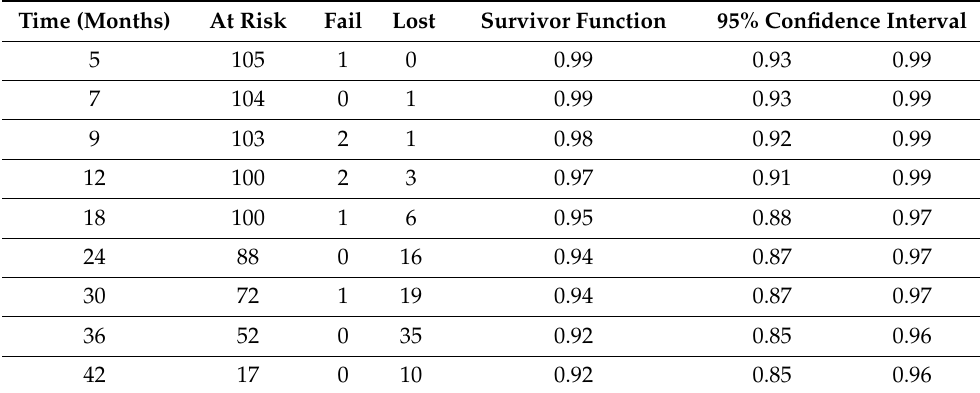
Table 2. Survivor functions at major time points of the entire